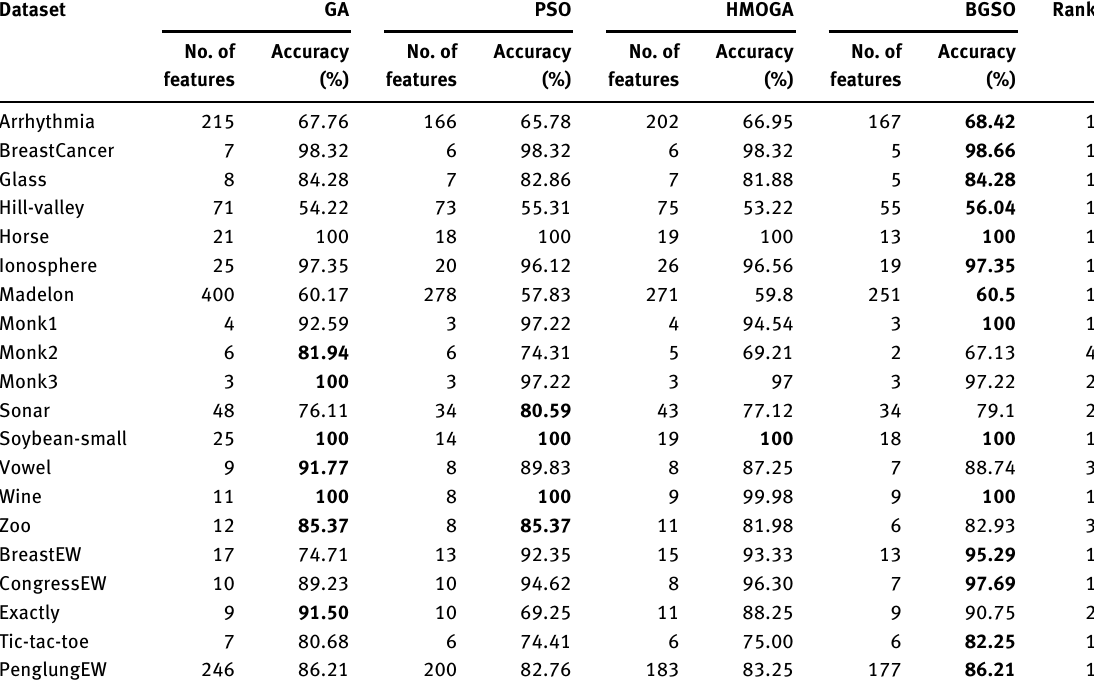
Table 4: Comparison of the Performance BGSO with Its Constituent Algorithms (GA and PSO) and HMOGA Using MLP Classifier.